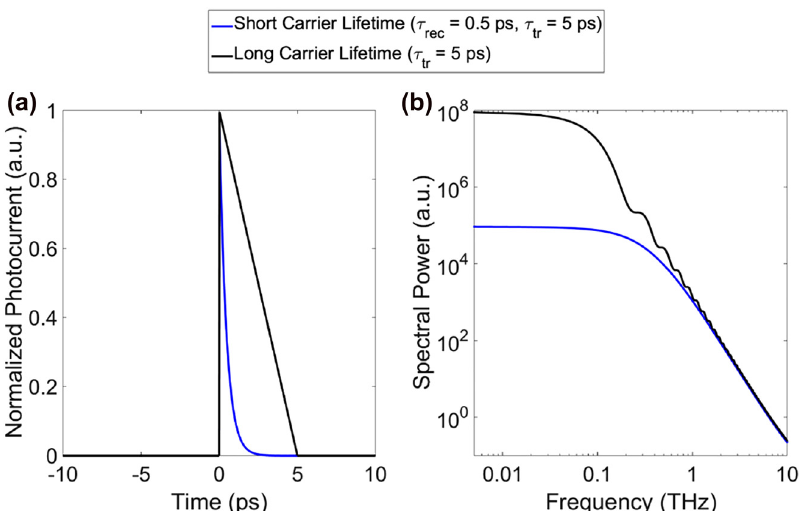
Figure 5: Time domain trace of the photocurrent amplitude (a) and the power spectra (b) of a long carrier lifetime and a shortcarrierlifetimephotoconductorunder pulsed